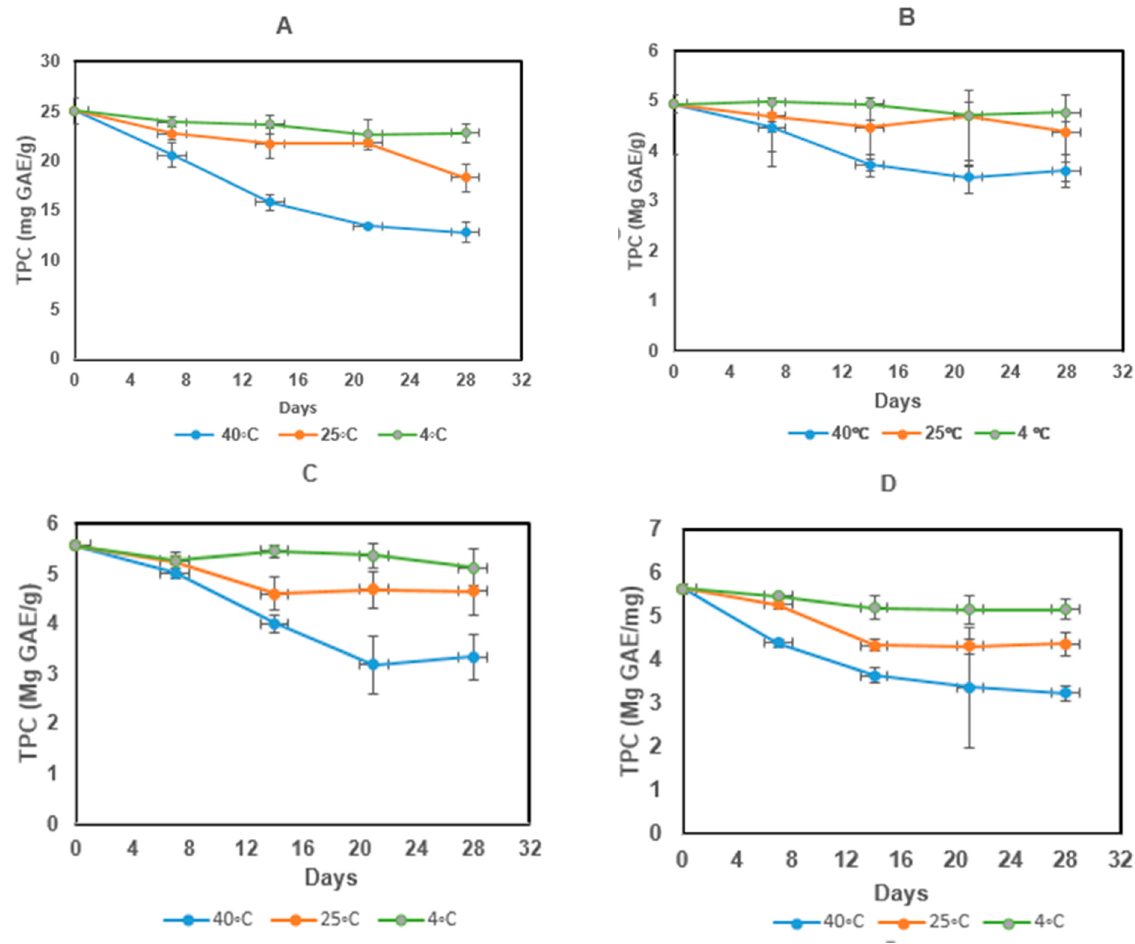
Figure 5. Total polyphenol contents at different temperatures for ( A ) M. oleifera extract ( B ) MDGA microcapsules ( C ) MD microcapsules ( D ) GA microcapsules.